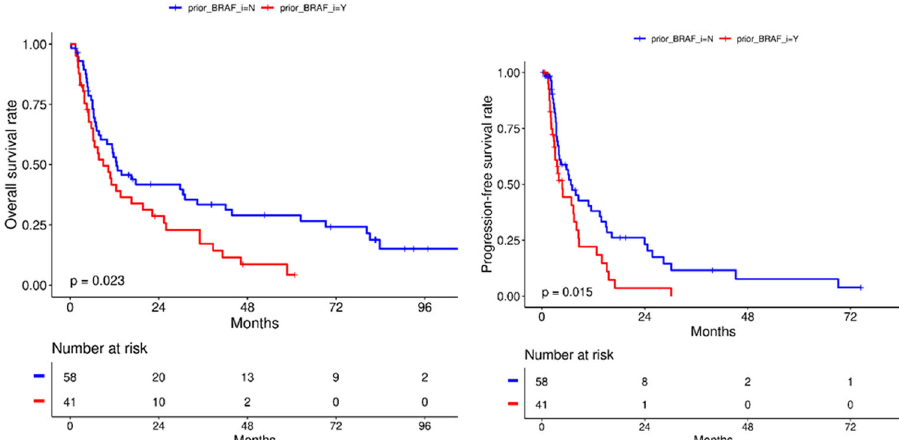
Fig. 2 Overall survival and progression-free survival outcomes in the 4 phase 1 trials. No clinically signi fi cant impact on survival outcomes were seen when vemurafenib monotherapy was compared with combination